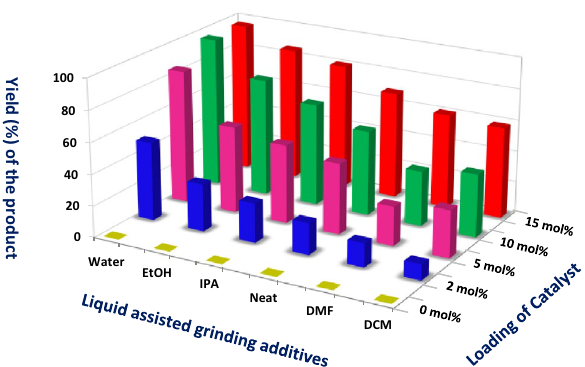
Figure 4. Screening of LAGs for the synthesis of 4a with different loading of the